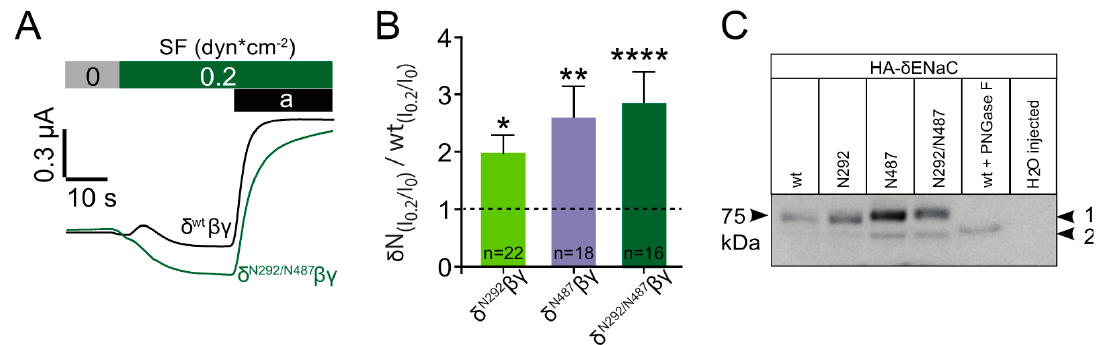
Figure 6. Insertion of N-glycosylation sites into δ ENaC increases the shear force effect. ( A ) Representative current traces of wild type δβγ ENaC and construct N292/N487 in response to shear force (SF). ( B ) The insertion of N-glycosylation motifs resulted in an increased shear force response (I 0.2 /I 0 ) in comparison with wild type δβγ ENaC (*, p < 0.05, **, p < 0.001, ****, p < 0.0001; with respect to wt channel indicated by dashed line, unpaired t -test). ( C ) Immunoblotting of whole-cell lysates from oocytes expressing HA-tagged human δ ENaC (wt, N292, N487 and N292/N487) co-expressed with βγ ENaC. The shift in relative molecular weight is observed between the wt (~75 kDa) and construct N487 as well as the N292/N487 construct (arrow 1). The molecular weight of construct N292 was similar to the wt δ subunit. PNGase F resulted in the complete loss of the upper band (arrow 2) and water-injected oocytes served as control. Blot is representative for n = 4. Current traces of experiments from oocytes expressing δ N292 βγ or δ N487 βγ are depicted in Figure